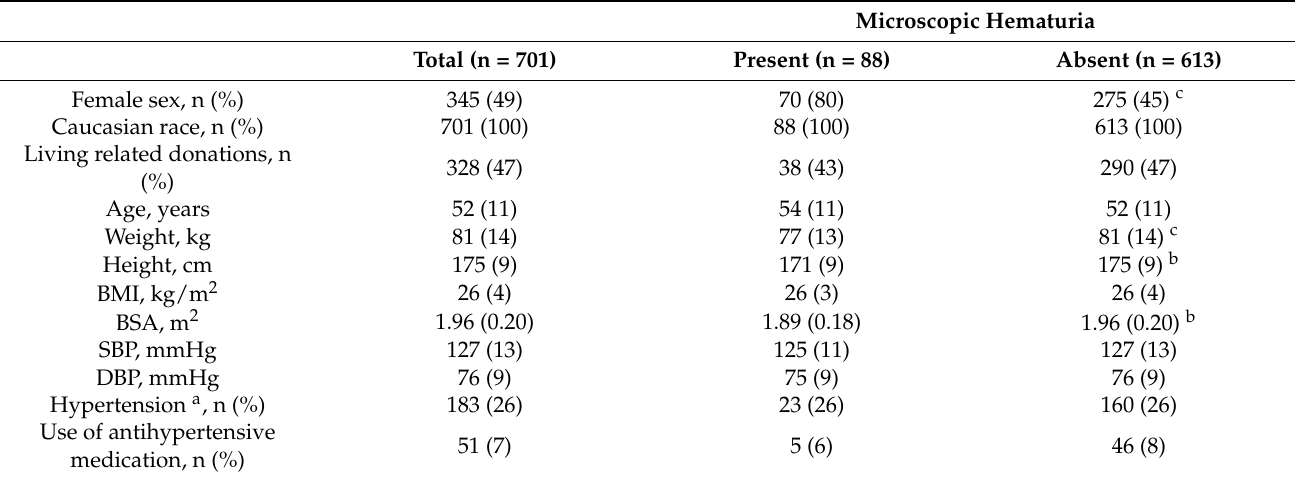
Figure 1. Overview of the study population selection. Table 1. Baseline characteristics of the living kidney donor population.